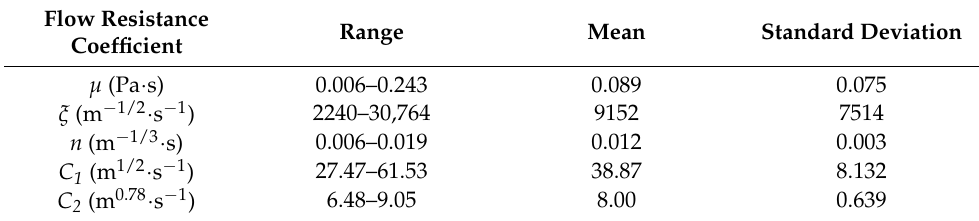
Table 7. Flow resistance coefficients calculated in this study. Flow Resistance